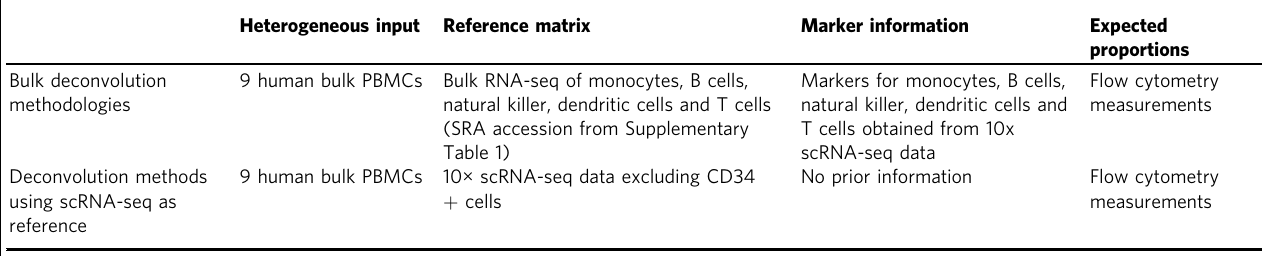
Table 2 Evaluation of deconvolution pipelines with real mixtures.